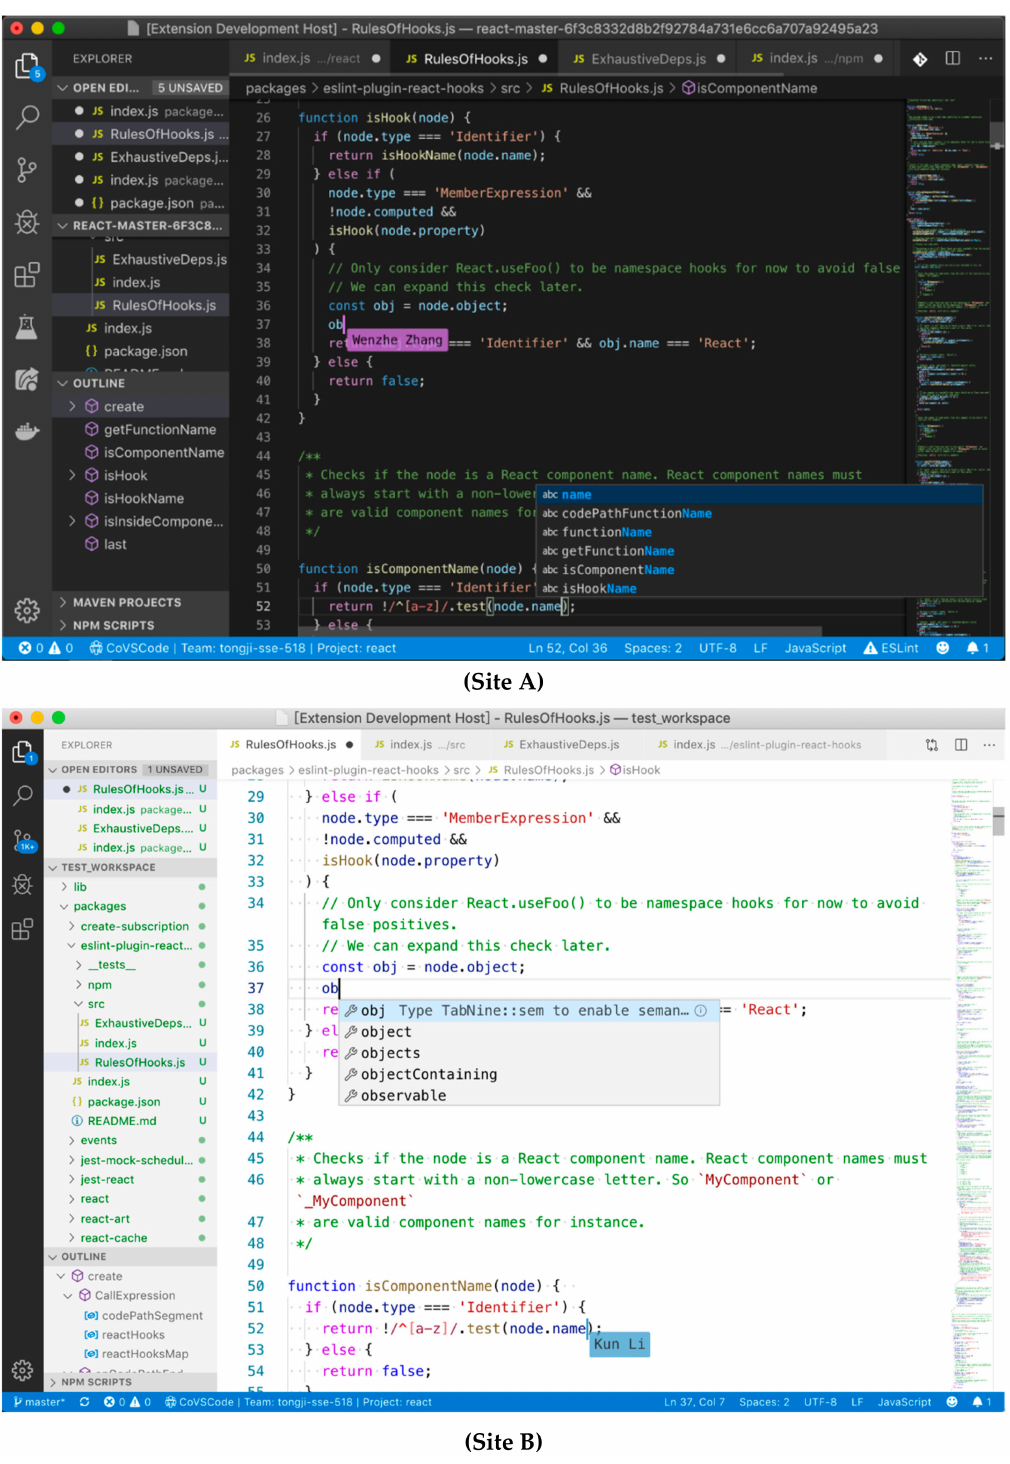
Figure 8. UI snapshots of two CoVSCode clients in a real-time collaboration